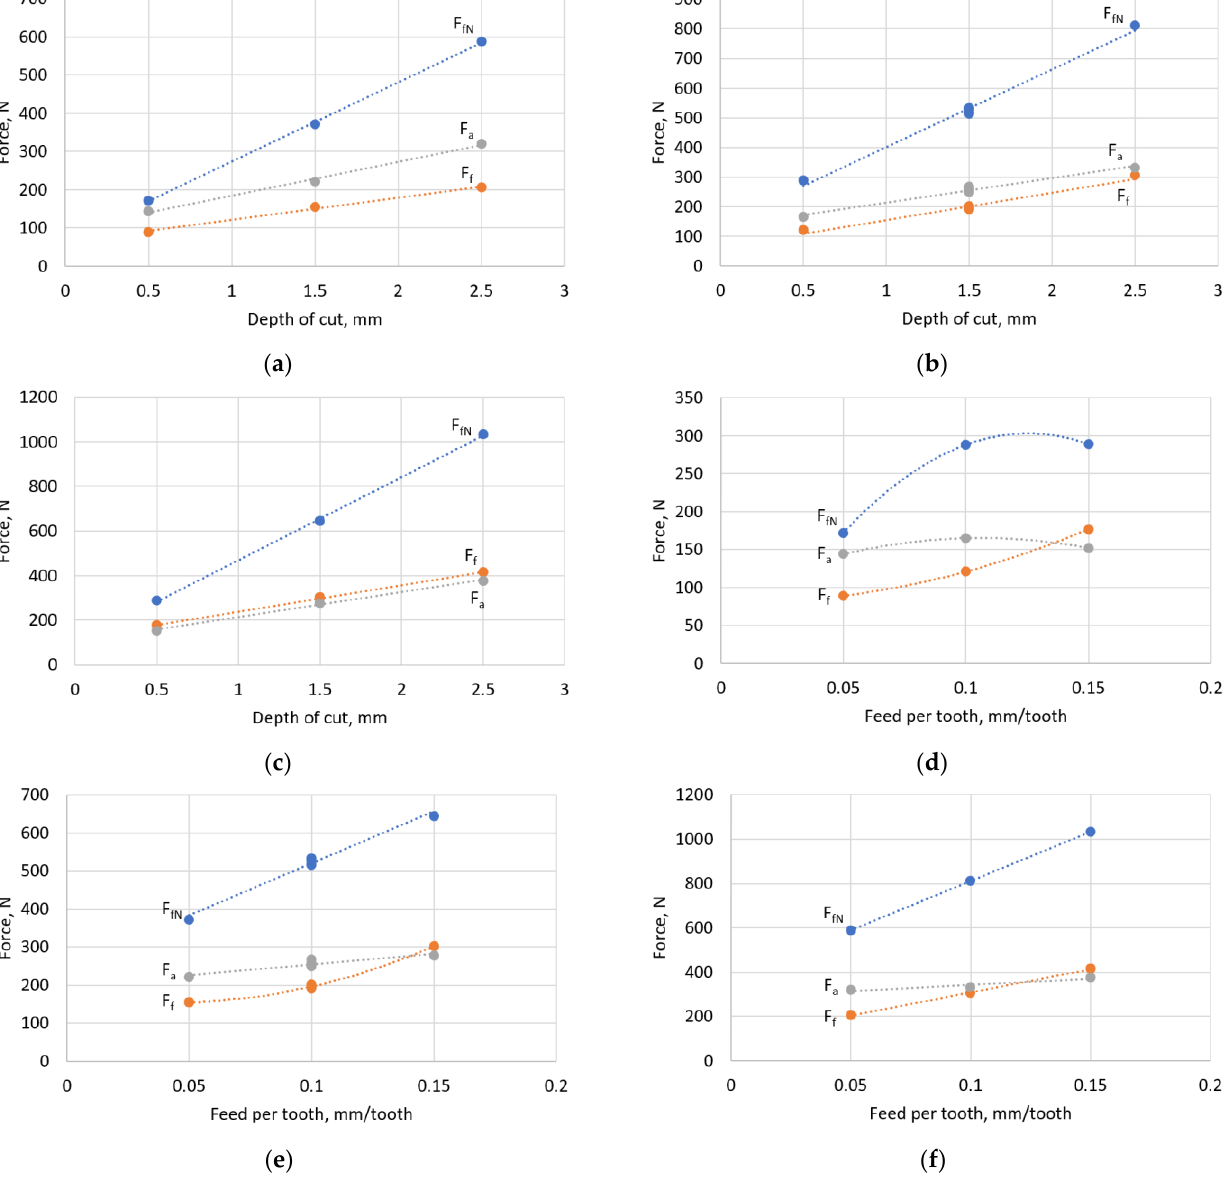
Figure 6. Components of the cutting force: ( a ) in the function of depth of cut, f z = 0.05; ( b ) in the function of depth of cut, f z = 0.1; ( c ) in the function of depth of cut, f z = 0.15; ( d ) in the function of feed, a p = 0.5; ( e ) in the function of feed, a p = 1.5; ( f ) in the function of feed, a p = 2.5.